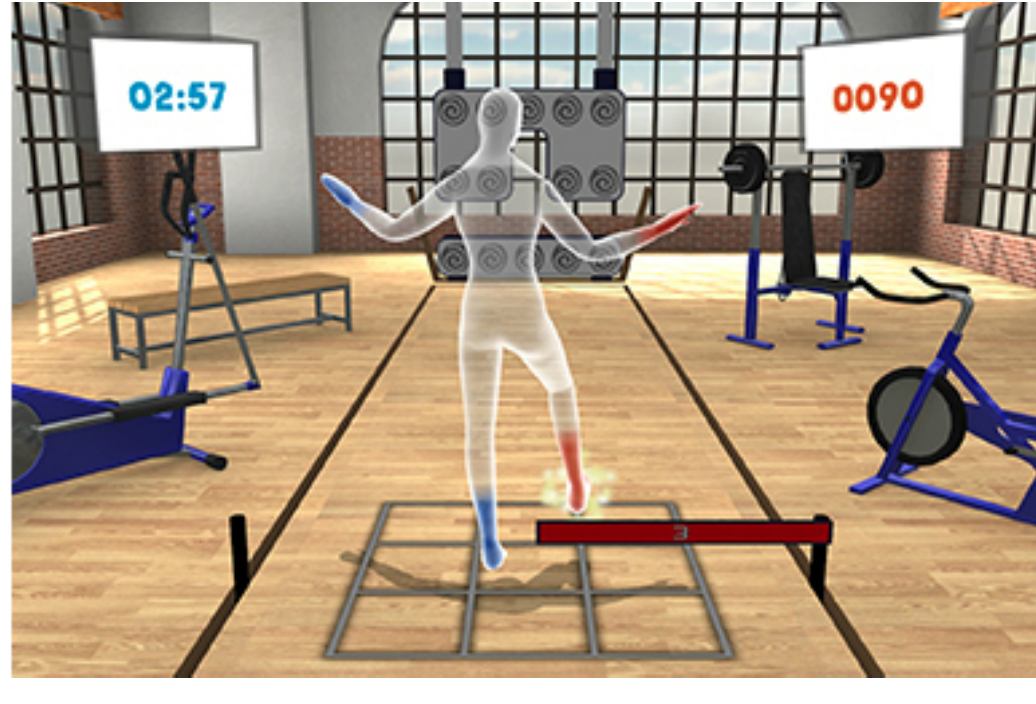
Figure 2. Arm Assist